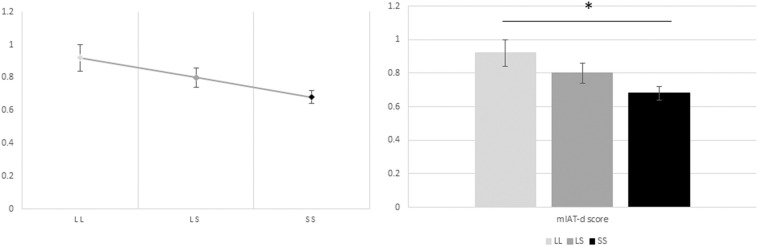
Relationship between the genotype groups and the D scores obtained from the mIAT. The one-way ANOVA yielded a statistically significant difference between genotype group mean D scores [F(2,111) = 3.432, p = 0.036]. Post hoc analyses revealed that D scores were significantly lower in those homozygous for the S allele (0.68 ± 0.042, mean ± SE, p = 0.024) when compared to those homozygous for the L allele (0.91 ± 0.071, mean ± SE, p = 0.024). There was no statistically significant difference, however, between the heterozygous (L/S)(0.80 ± 0.058, mean ± SE) and the homozygous (S/S and L/L) groups of alleles (p = 0.069 and p = 0.318, respectively). The subsequent ANCOVA showed that the difference between genotype group mean D scores remained statistically significant also when controlling by age and gender [F(2,109) = 3.242, p = 0.043, ηp2 = 0.056]. Post hoc analyses further underlined the statistically significant difference between the lower mean D scores among those homozygous for the S allele and the higher D scores among those homozygous for the L allele (p = 0.024), whereas the difference in means between those with heterozygous alleles (L/S) and those with homozygous alleles (S/S and L/L) remained non-significant (p = 0.102 and p = 0.276, respectively). Likewise, the linear regression analysis exhibited a statistically significant linear association between genotype group (number of risk allele “S”) and mIAT D scores [F(3,110) = 2.514, p = 0.012, R2 = 0.064], and controlling for age and gender. Accordingly, there is a decrease of 0.117 points in the participants’ D scores as a function of a one increase in S alleles being carried.